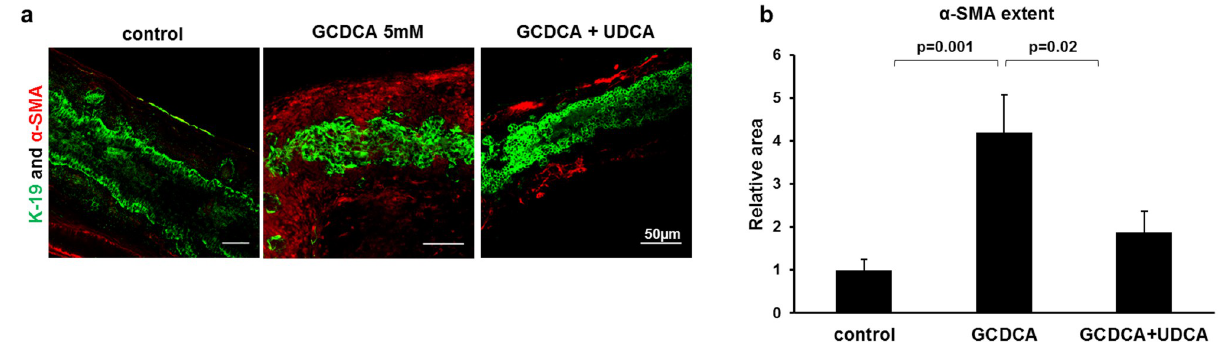
Fig 2. Glycochenodexycholic (GCDCA) causes lumen obstruction and subepithelial fibrosis of neonatal extrahepatic bile ducts (EHBDs), while ursodeoxycholic acid (UDCA) attenuates GCDCA toxicity. (a) Neonatal EHBD were dissected and incubated for 24 hours in biliary epithelial cell media, with or without GCDCA 5mM, and with GCDCA 5mM combined with UDCA acid 5mM. Immunofluorescent staining for the cholangiocyte marker K19 (green) and the myofibroblast marker α -SMA (red) demonstrated an ameliorating effect of UDCA, with increased lumen integrity and decreased fibrosis. Scale bar, 50 μ m. (b) Quantification of the total α -SMA positive area in the bile ducts (control 1 ± 0.255 (n = 20), GCDCA 4.19 ± 0.87 (n = 21), GCDCA +UDCA 1.87 ± 0.48 (n = 15)). Data represent mean ± standard error of the mean, N = 4 independent experiments.